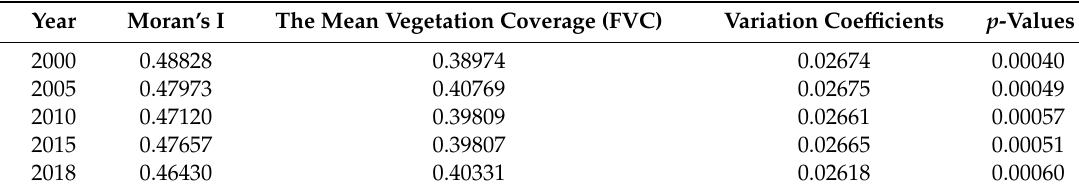
Table 2. Moran’s I mean and coe ffi cient of variation of vegetation